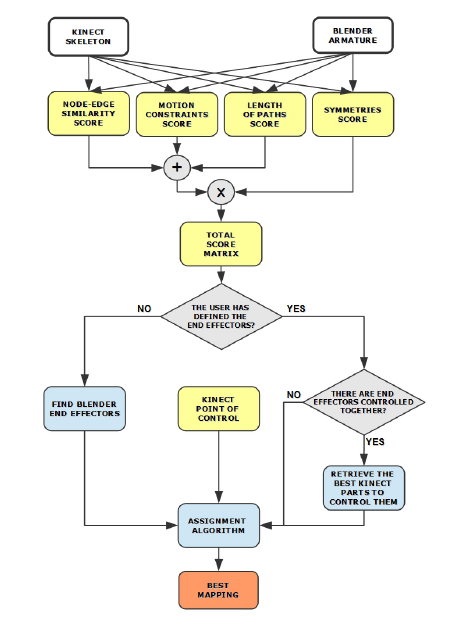
Figure 6. Flow-chart of the second mapping